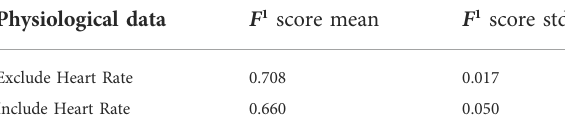
TABLE 3 The effect of heart rate (HR) on cybersickness